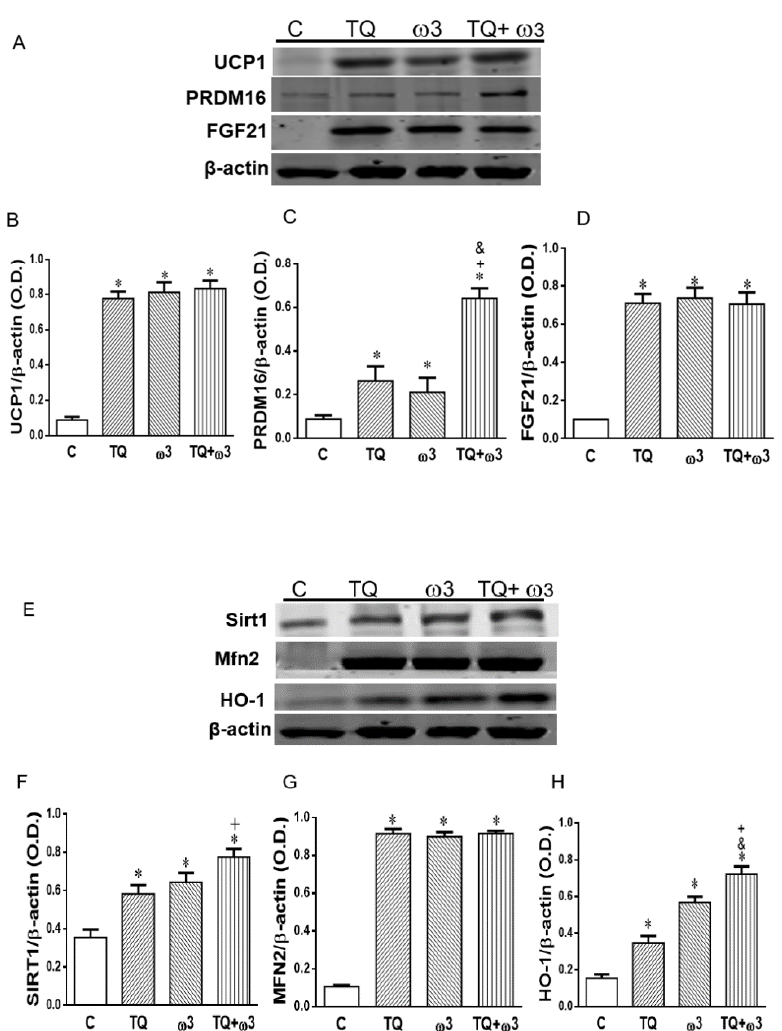
Figure 2. Effects of thymoquinone (TQ) and omega-3 ( ω 3) treatment on the protein expression of beige adipocytes and key regulators of mitochondrial biogenesis in 3T3-L1 adipocytes. Representative and graph of uncoupling protein 1 (UCP-1), PR domain containing 16 (PRDM16), and fibroblast growth factor 21 (FGF21) ( A – D ); Sirtuin 1 (Sirt1) Mitofusion 2 (Mfn2), and heme oxygenase-1 (HO-1) protein expression ( E – H ). 3T3-L1 adipocytes were treated with TQ 2 µ M, ω 3 20 µ M, and a combination of TQ and ω 3 for six days ( n = 4). * p < 0.05 vs Lean; + p < 0.05 vs TQ; & p < 0.05 vs ω 3.